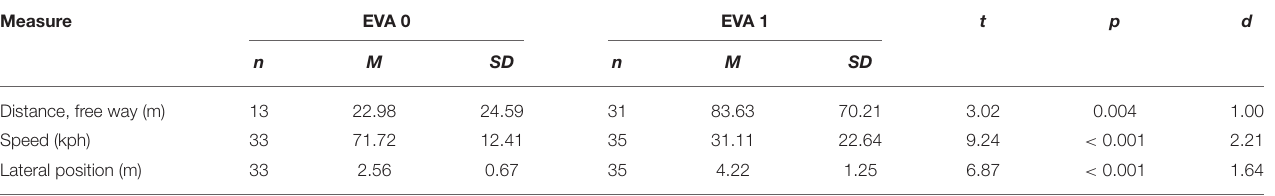
TABLE 1 | Descriptive statistics for the experimental and control groups, respectively, and inferential statistics for the differences. Measure EVA 0 EVA 1 t p d n M SD n M SD Distance, free way (m)